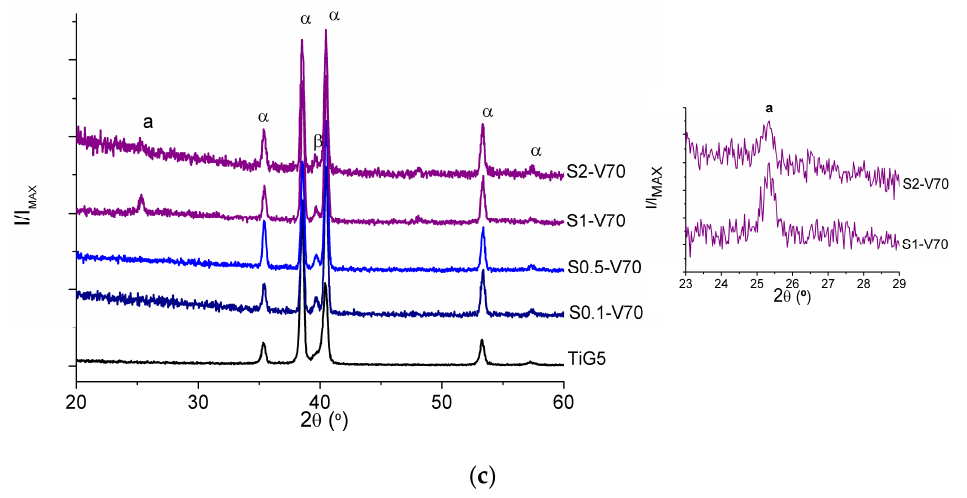
Figure 4. XRD patterns of the substrate and oxidized samples with different electrolytes at different voltages: ( a ) 40 V; ( b ) 60 V; ( c ) 70 V. a = anatase, α = α phase of TiG5, and β = β phase of TiG5.